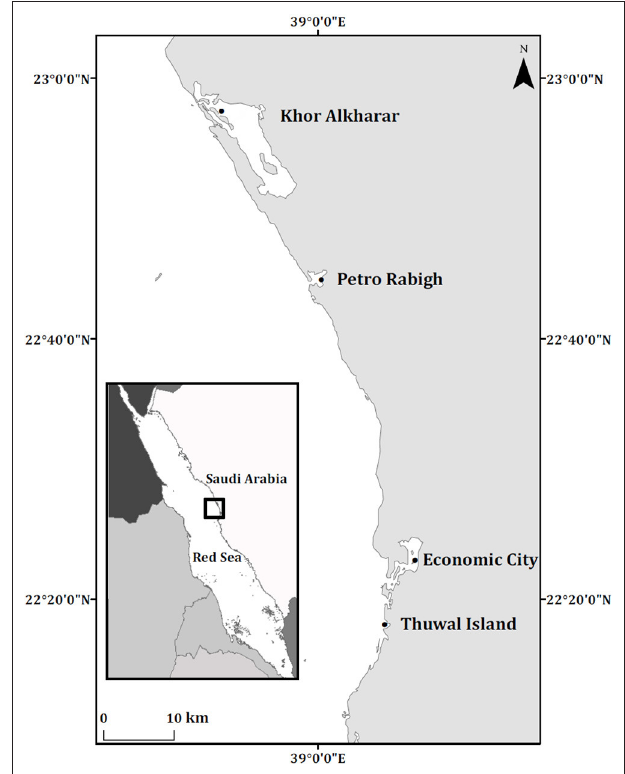
FIGURE 1 | Location of the Central Red Sea mangrove stands sampled. The map was produced using ArcMap Version 10.2.